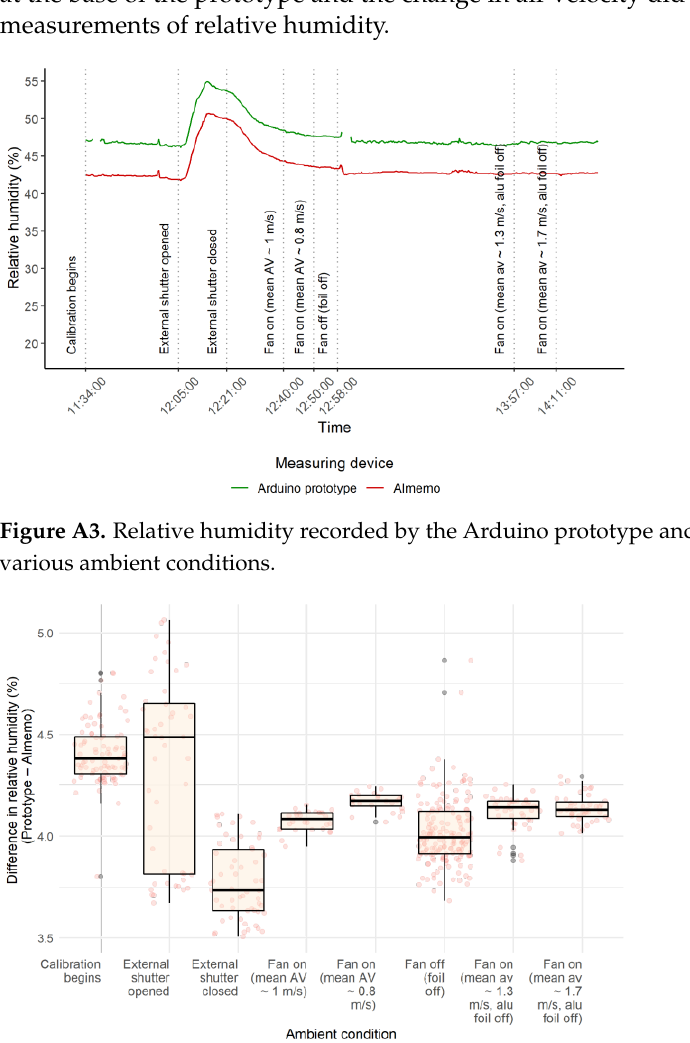
Figure A5. Air (ta), globe (tg) and mean radiant temperature (mrt) recorded by the Arduino proto- type and Almemo instrument during various ambient conditions.